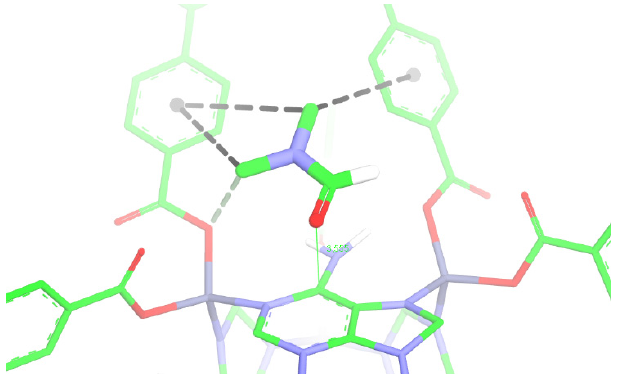
Figure 8. Docking poses for the best-scored solvent molecule hosted in one of the channels of the simulated structure for RCA. All non-polar H-atoms have been omitted for better visualization. In the pose, C-atoms are represented in green, N-atoms in blue, O-atoms in red, Zn (II)-ions in gray, and polar H-atoms are blank/white. Intermolecular contacts are represented by black dashed lines.